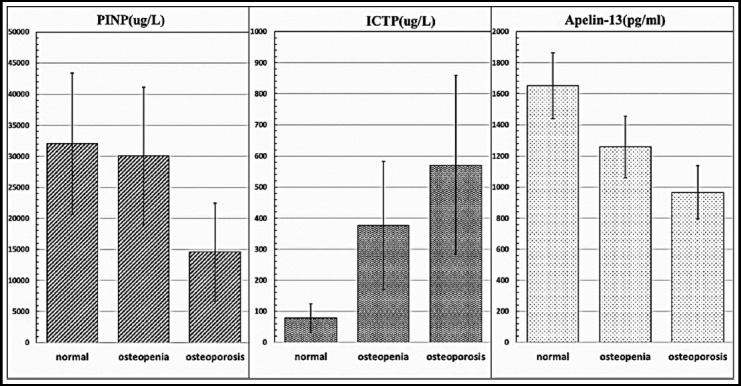
The comparison of PINP, ICTP and Apelin-13 in normal, osteopenia and osteoporosis groups.